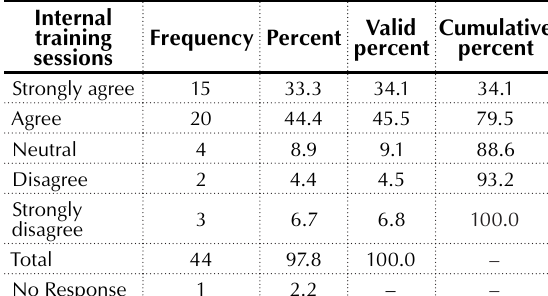
Table 6. Responses on internal training sessions